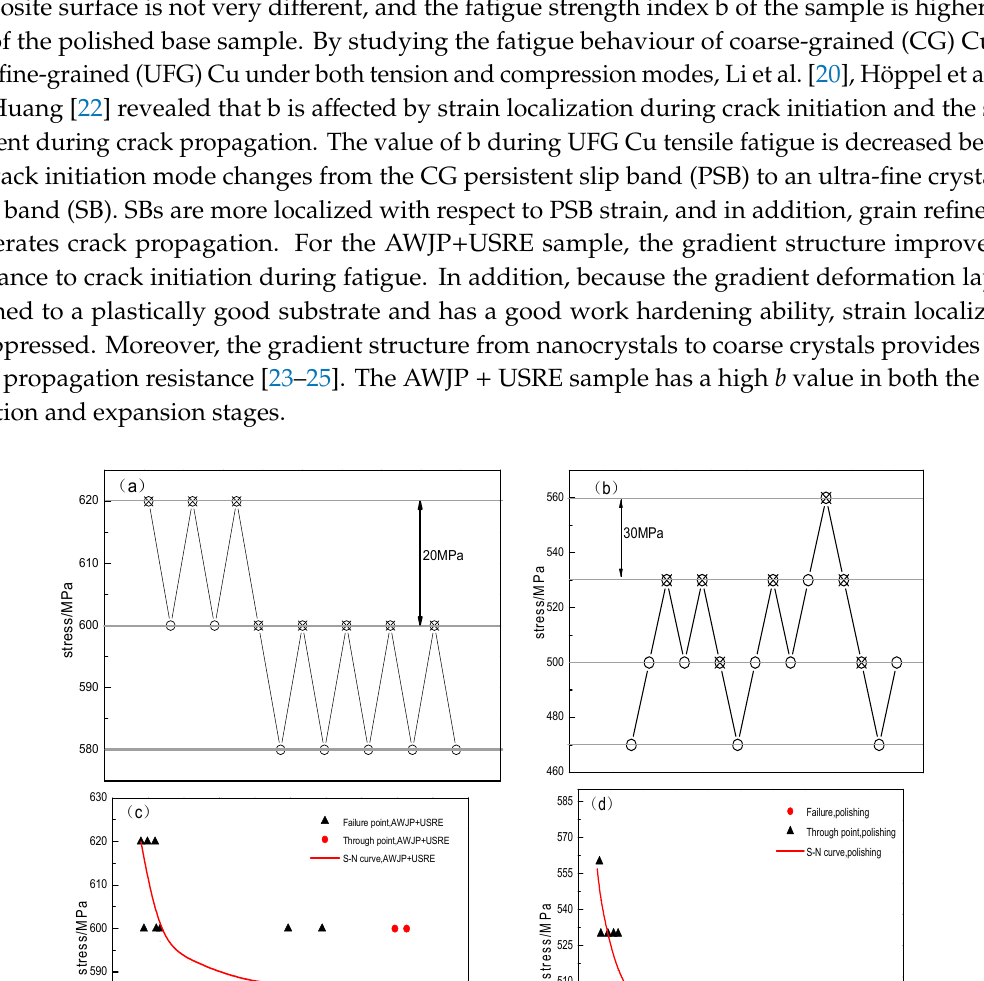
contact generates a stress field on the surface of the material. Each small volume unit was plastically